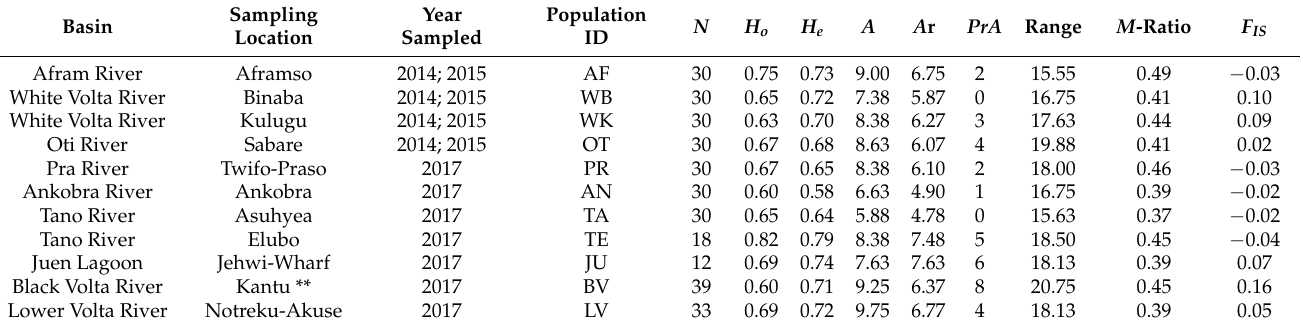
** The majority of Black Volta River samples were obtained from Kantu ( N = 30). Samples were also collected from Lawra ( N = 3) and Talewona ( N = 6).